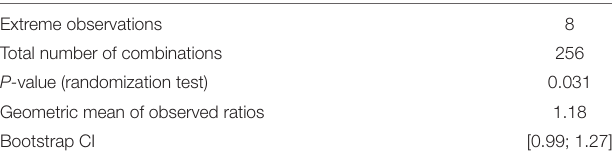
TABLE 2 | Results of the randomization test and bootstrap normal CI. Extreme observations 8 Total number of combinations